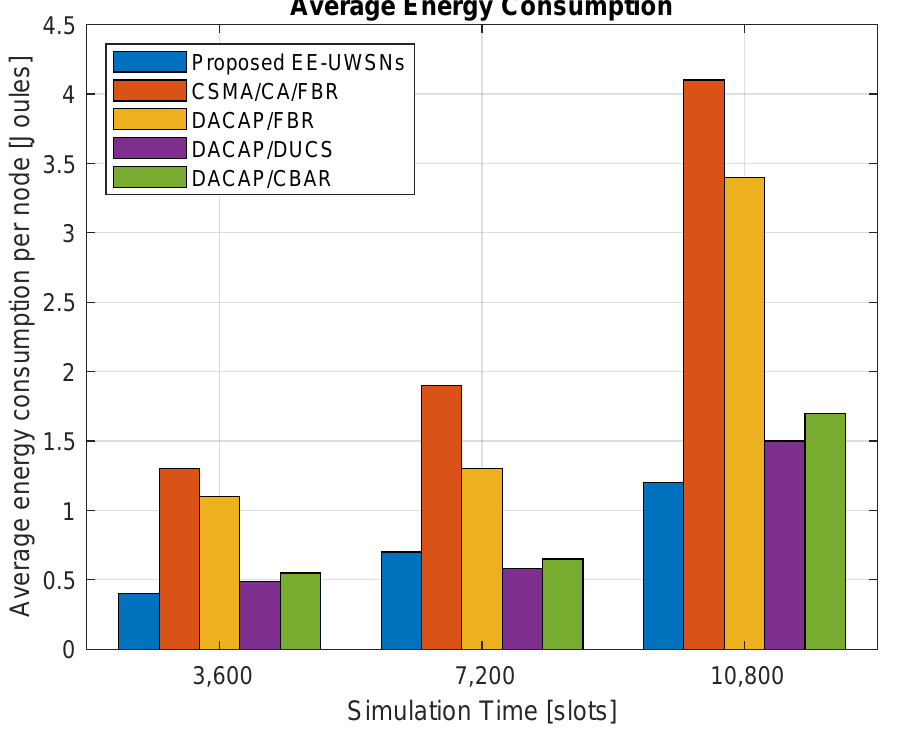
Figure 9. Average energy consumption per node. Figure 10 studies the average number of collisions during different simulation